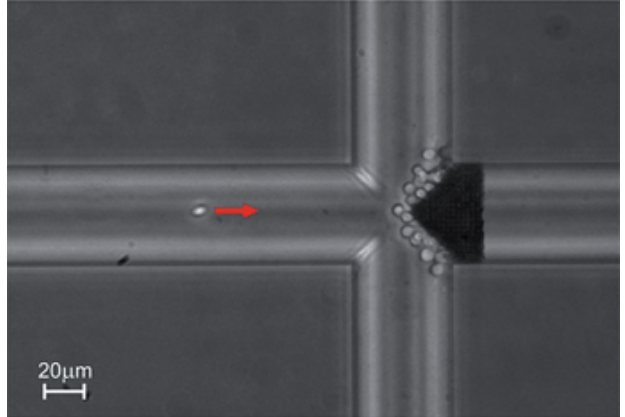
Figure 24 . Microscope image of red blood cells filtered from plasma with a micro-porous filter, printed with MPP [138]. (Republished with permission of Royal Society of Chemistry, from [Lab on a chip, L. Amato, et al., Volume 12, Issue 6, Pages 1135-1142, 2012]; permission conveyed through Copyright Clearance Center, Inc).